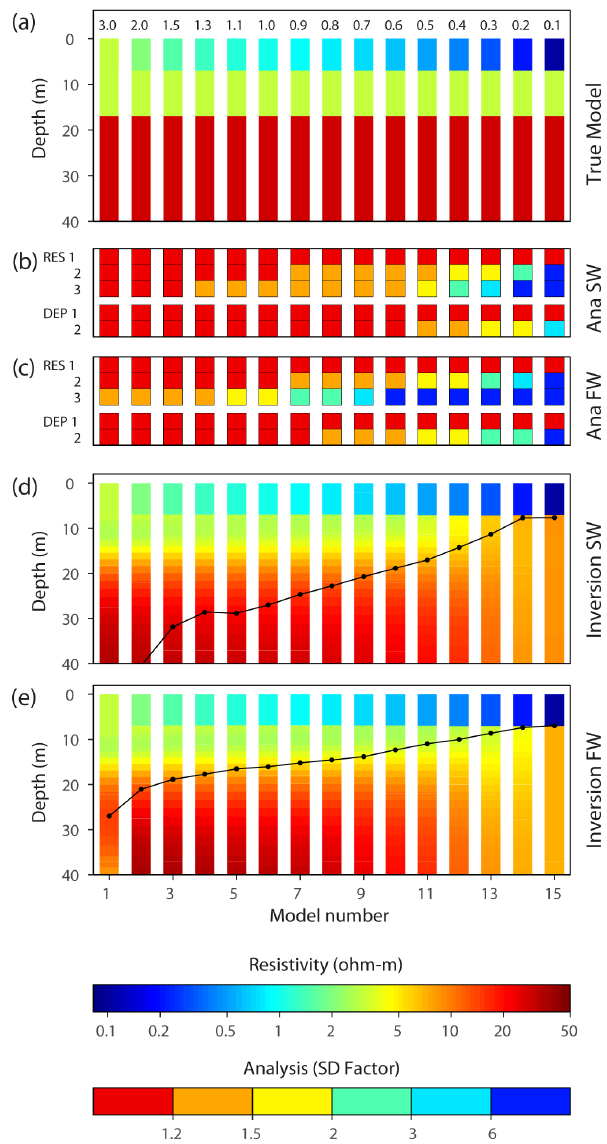
Figure 3. Model sweep 2. (a) True model. The number on top of each model bar states the resistivity of the water (resistivity of first layer). (b, c) Model parameter analysis of the true model, stated as standard deviation factor, for the SW-FloaTEM and FW- FloaTEM systems. (d, e) Inversion results for SW-FloaTEM and FW-FloaTEM systems. The black line shows the